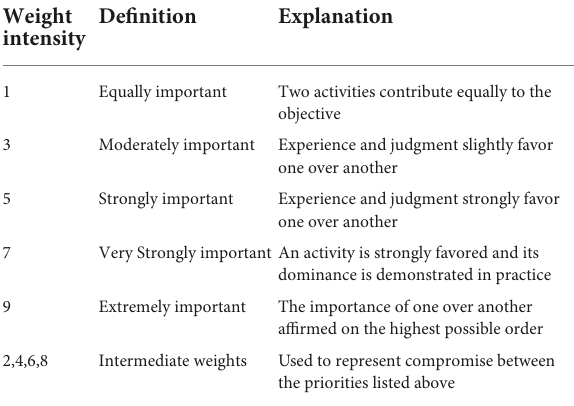
TABLE 1 Saaty’s 1–9 scale for pairwise